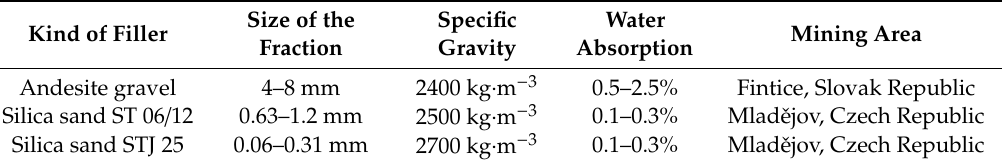
Table 1. The characteristics of the organic